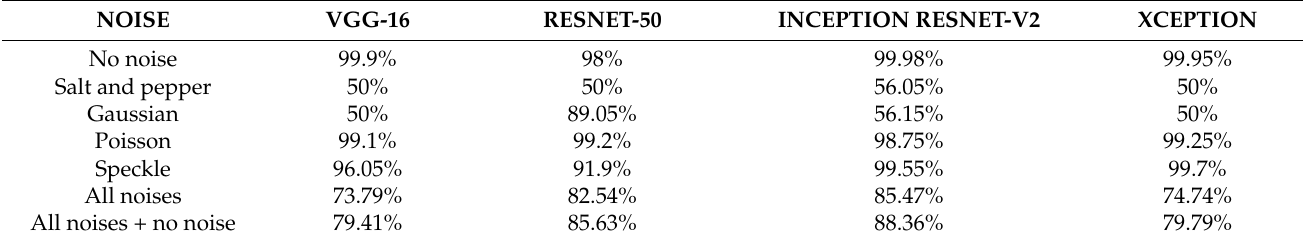
Table 3. Accuracy with and without noise.